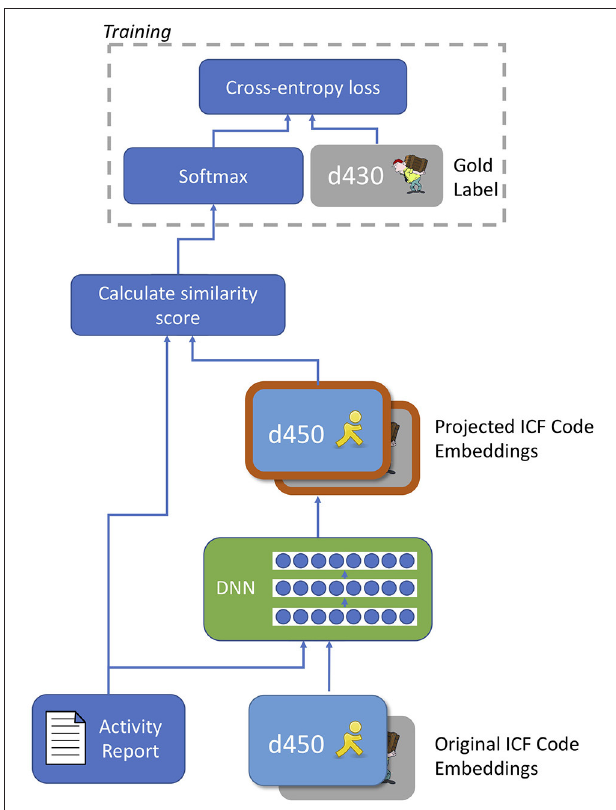
FIGURE 4 | Diagram of novel context-dependent projection model for code embeddings. The deep neural network (DNN) takes an activity report and an individual code embedding as input and produces a projected version of the code embedding as output. The same DNN was applied to all code embeddings; similarity scoring is performed using the combined cosine similarity and projection magnitude method of Sabbir et al. ( 63). After training the model, the softmax operation is removed and similarity scores are produced as